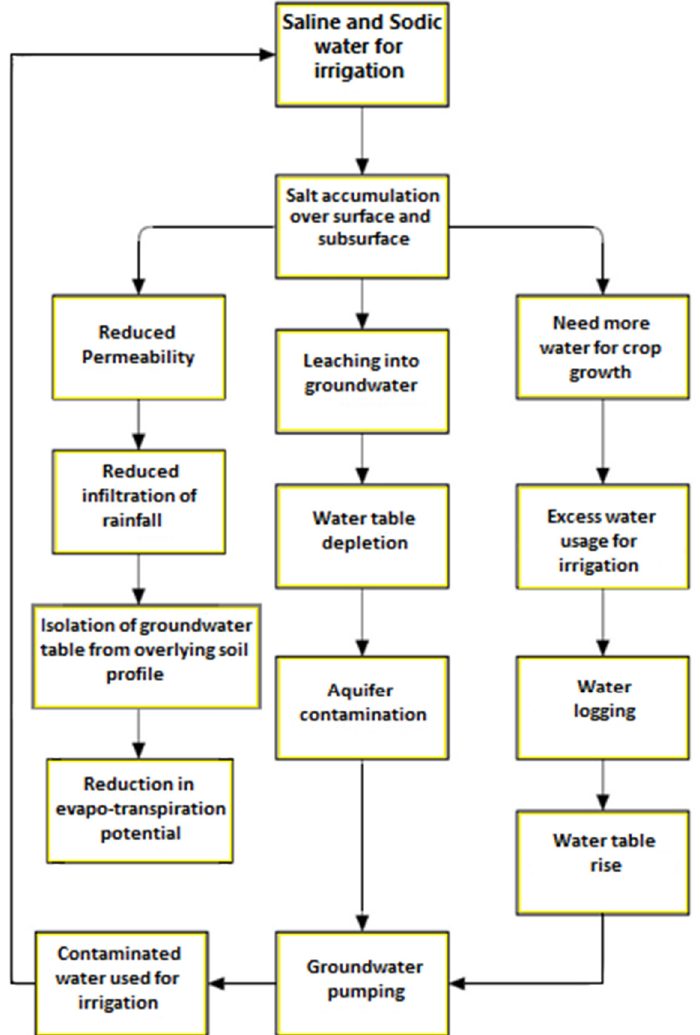
Figure 2. Effects of irrigation-induced salinity and sodicity hazards on groundwater.